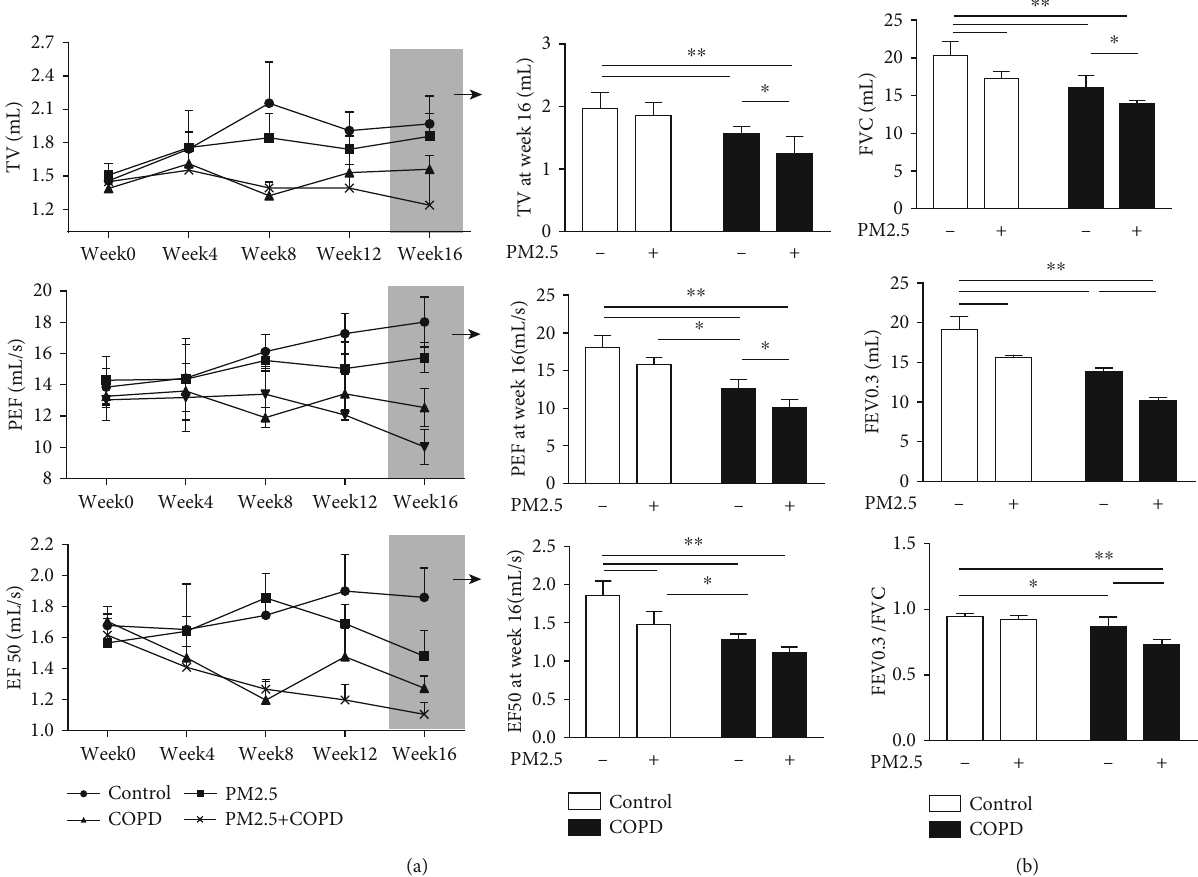
Figure 4: The e ff ect of PM2.5 on pulmonary function in rats with COPD. (a) The change of noninvasive lung function parameters TV, PEF, and EF50 of rats in each group from week 0 to week 16, as well as at week 16. (b) The change of invasive lung function parameters FVC, FEV0.3, and FEV0.3/FVC of rats in each group at week 16. TV: tidal volume; PEF: peak expiratory fl ow; EF50: expiratory fl ow 50%; FVC: forced vital capacity; FEV0.3: forced expiratory volume at 0.3s; FEV0.3/FVC: forced expiratory volume at 0.3 s/forced vital capacity. The data are expressed as the means ± SD ( n = 7 ). ∗∗ p < 0 : 01 , ∗ p < 0 : 05